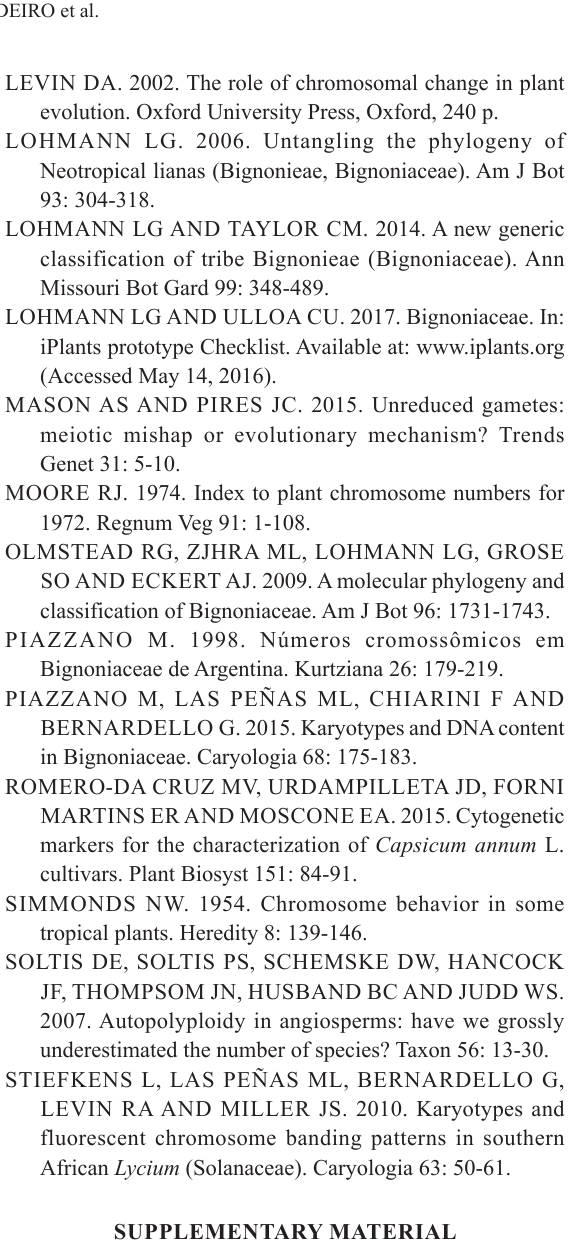
TABLE SI - Chromosome numbers recorded for the tribe Bignonieae and their respective bibliographic references. TABLE SII - Species of the tribe Bignonieae (Bignoniaceae) analyzed and their main karyological parameters. Legend: A - large telomeric CMA + bands, B - small telomeric CMA + bands, C - proximal CMA + bands, D - telomeric and proximal CMA + bands, E - two telomeric CMA + bands, F - absence of heterochromatic